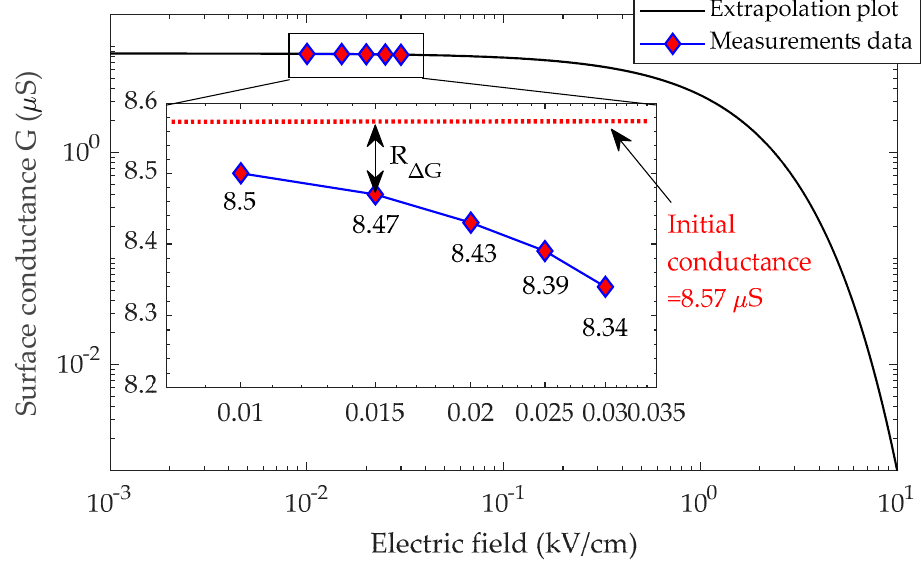
Figure 9. Relationship between the conductance and electric field for insulator type II.